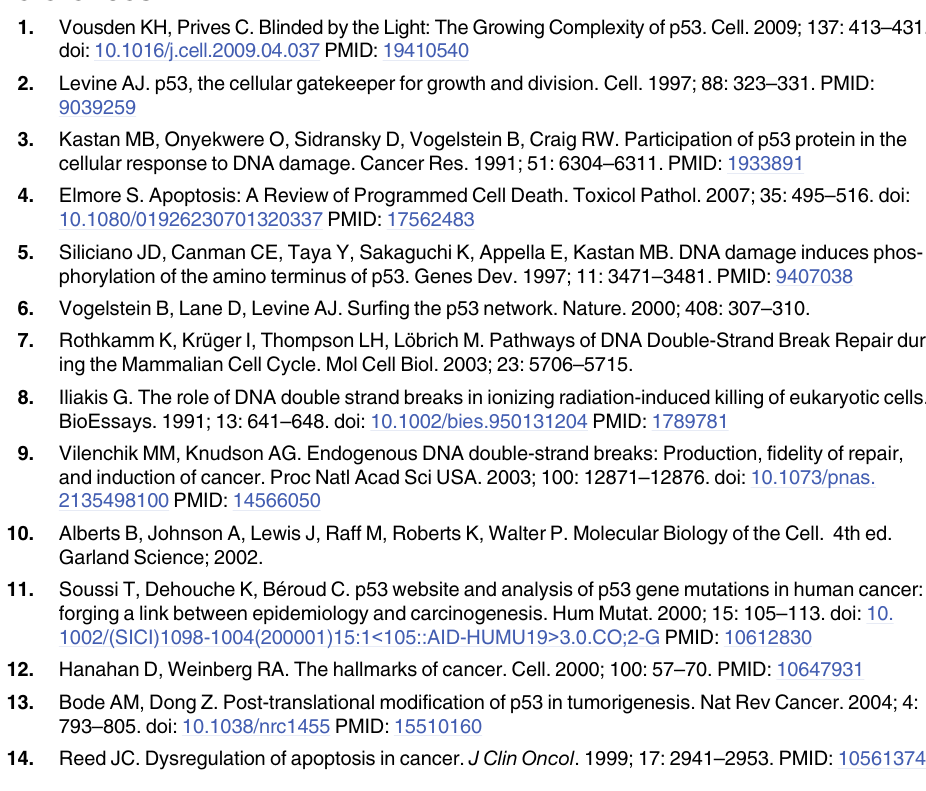
S5 Fig. A hypothetical alternative bifurcation structure for the core module. The stable limit cycle (of envelope marked by pairs of blue points) coexists with a high-level stable steady state and disappears through the saddle — loop bifurcation (SL). The stable and unstable steady states are indicated by solid and dashed lines, respectively; red dots labeled SN mark saddle — node